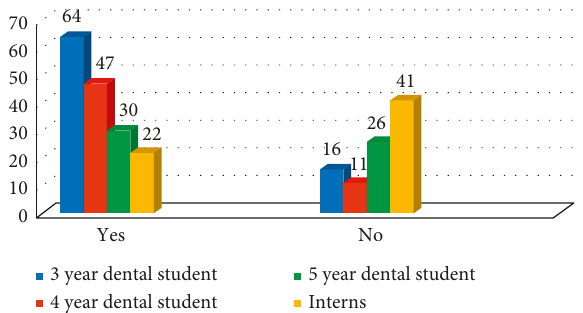
Figure 3: Response of participants if dental X-ray is harmful ( χ 2 5.60 with P 0 . 469). (cid:31) >